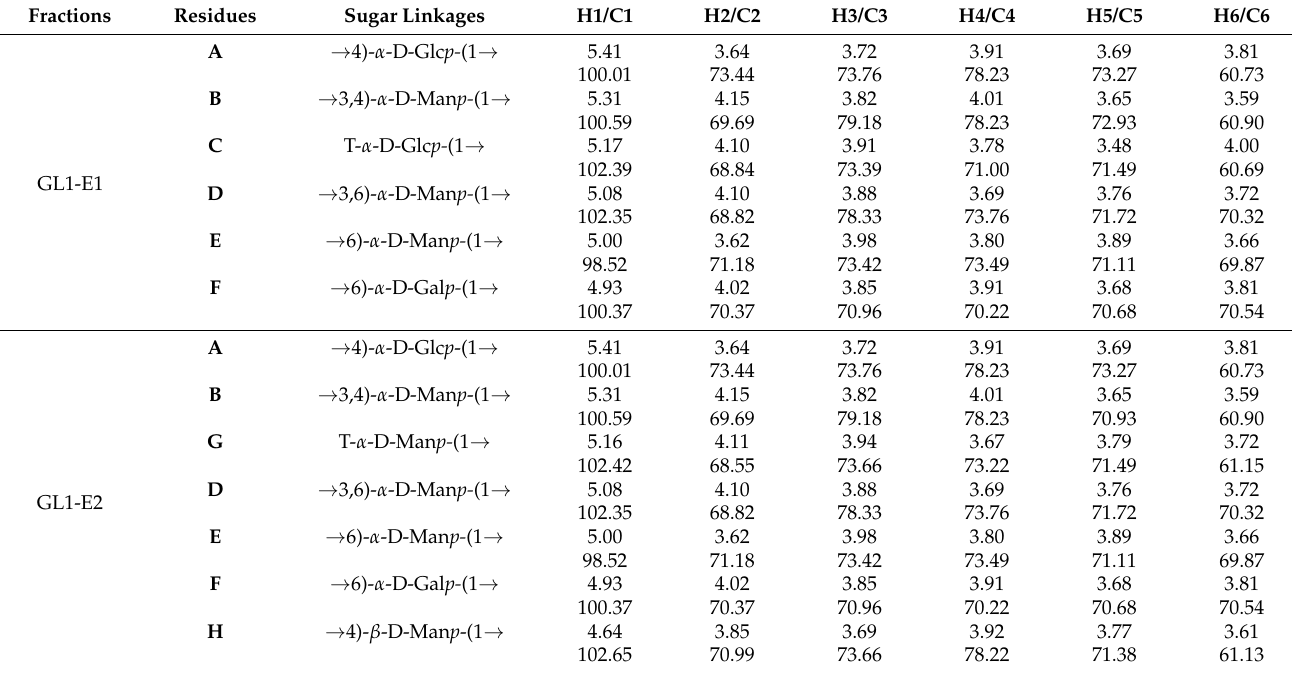
Table 2. Chemical shifts (ppm) of the 1 H and 13 C signals for those recorded in D 2 O at 313 K. Fractions